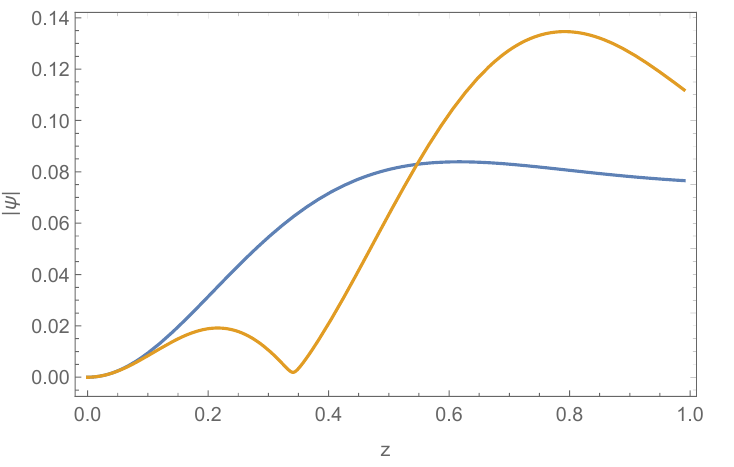
Figure 1 . The eigenfunction ψ and q = 6 . 5 . The overtone number corresponds to the node